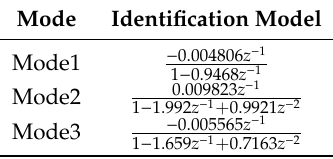
Table 1. Continuous stirred tank reactor (CSTR) identification model at three operating